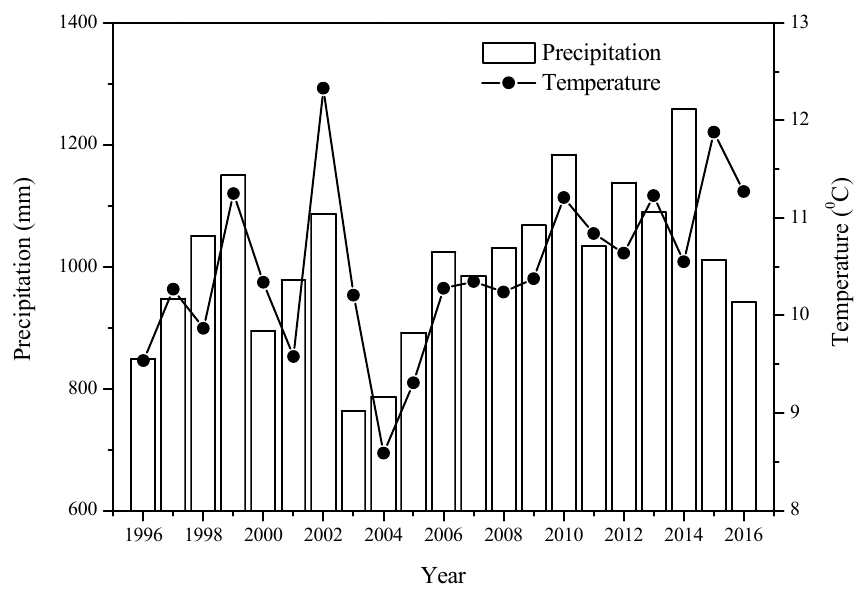
Figure 2. The variation in the mean annual temperature and total precipitation in the Huoditang forest region from 1996–2016. The data were sourced from the unpublished Qinling long-term ecological monitoring database.